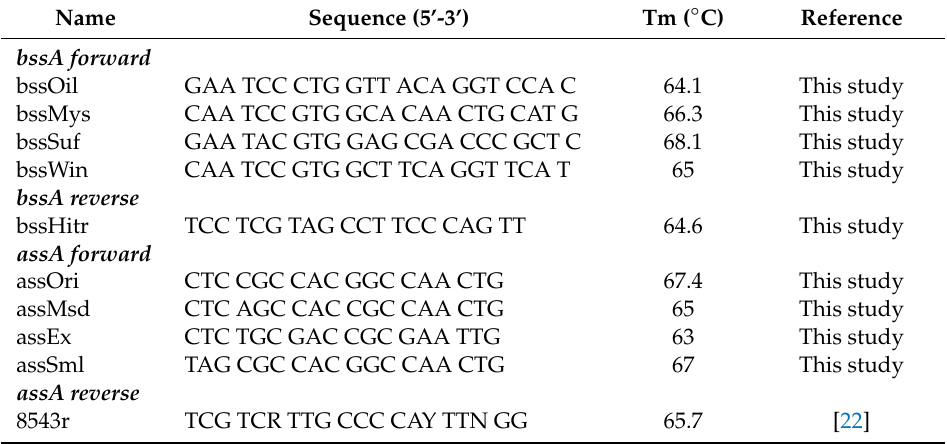
Table 1. Primers designed and used in this study for quantitative detection of the bssA and assA genes in Site A and B groundwater samples. Melting temperature T m was calculated via the IDT OligoAnalyzer 3.1 online tool using default quantitative polymerase chain reaction (qPCR)